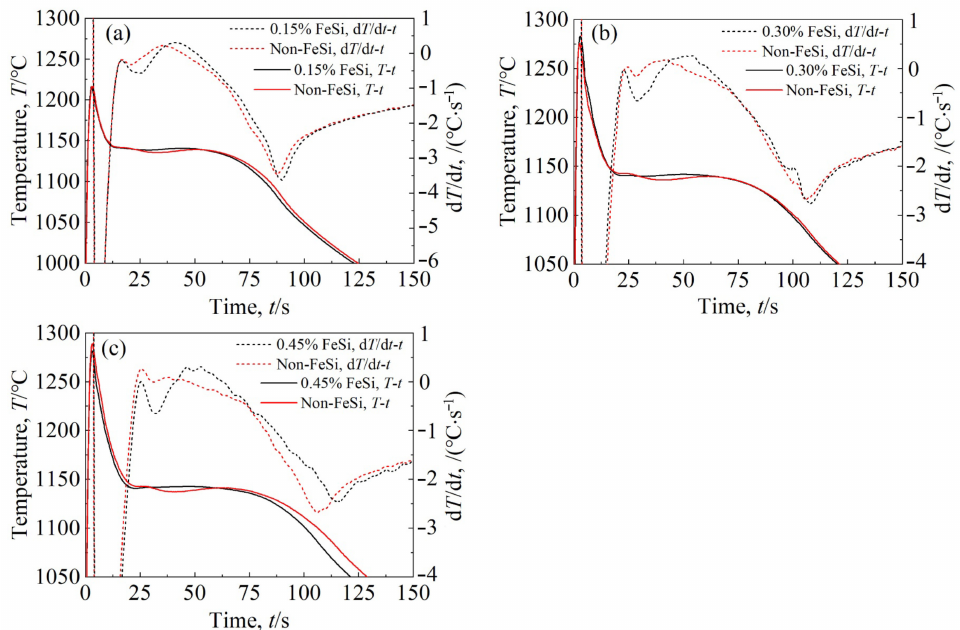
Figure 7. Cooling curves and differential curves with different amounts of FeSi75: ( a ) 0.15% FeSi75,